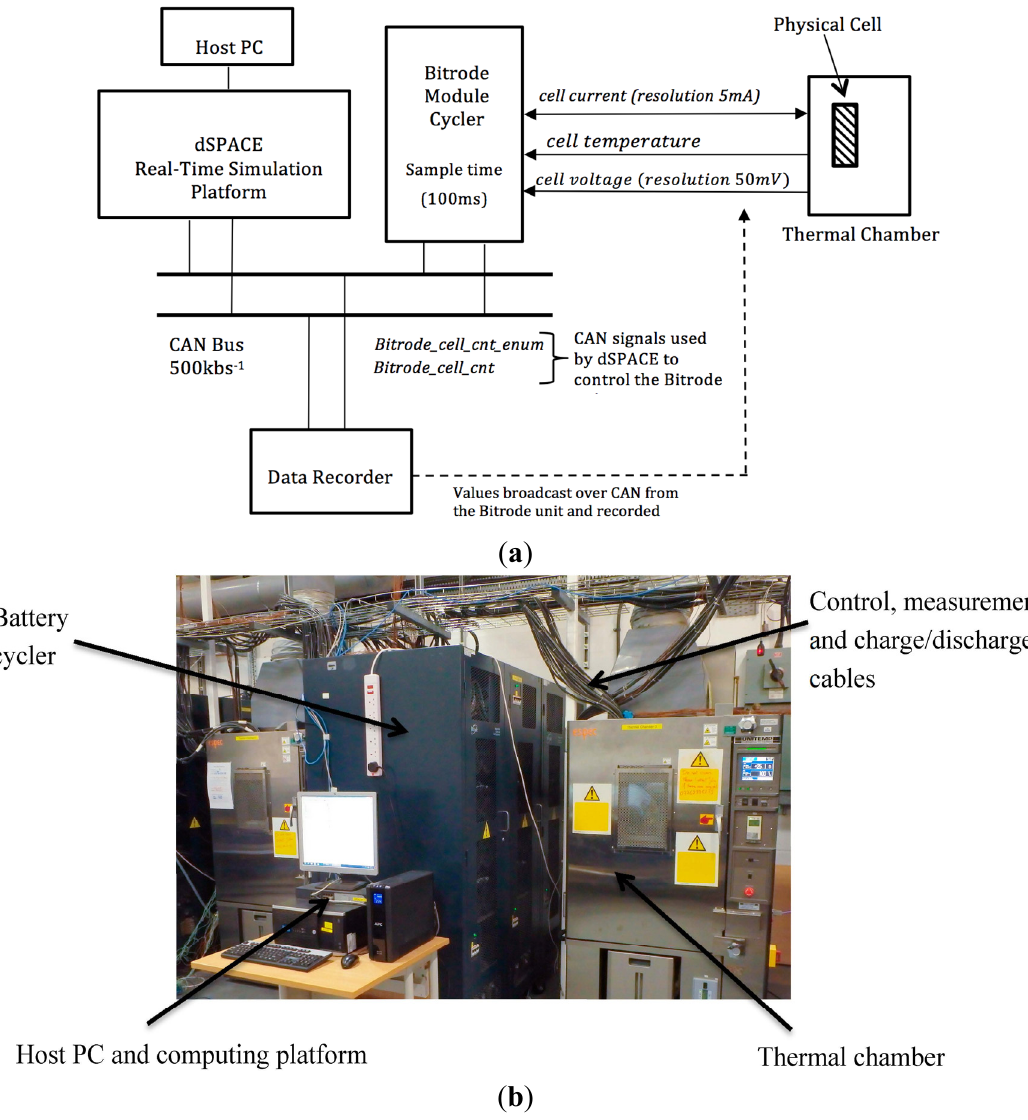
Figure 5. ( a ) Schematic of the experimental set-up for cell-in-the-loop simulation (CILS); ( b ) laboratory set-up for